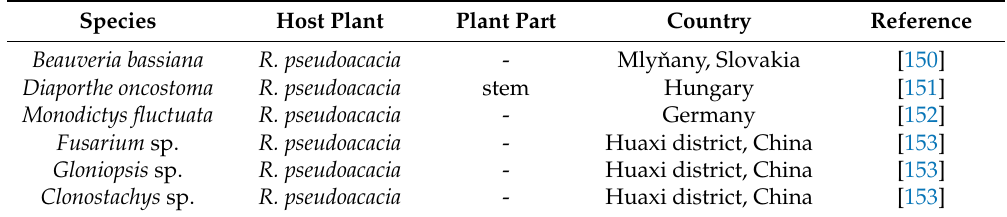
Table 14. Endophytic fungi isolated from Robinia